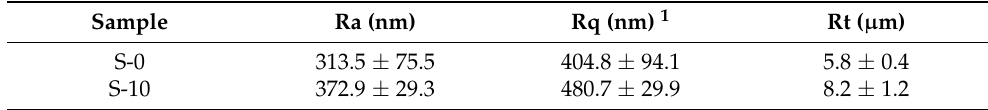
Figure 6. Roughness map of the selected samples: ( A ) non–modified sample (S-0) and ( B ) sample modified for 10 s (S-10). Table 2. Roughness parameters of the selected